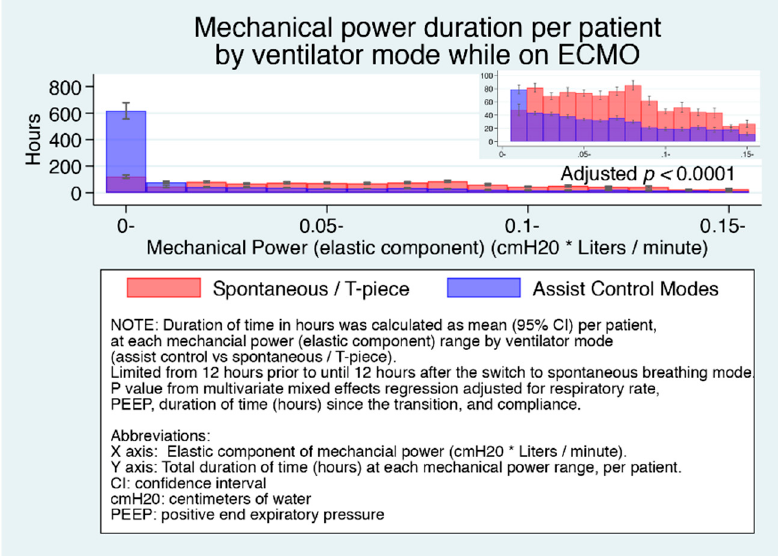
Figure 3. Duration of time (median, 95% CI) per patient at each mechanical power (elastic component) range by ventilator mode.